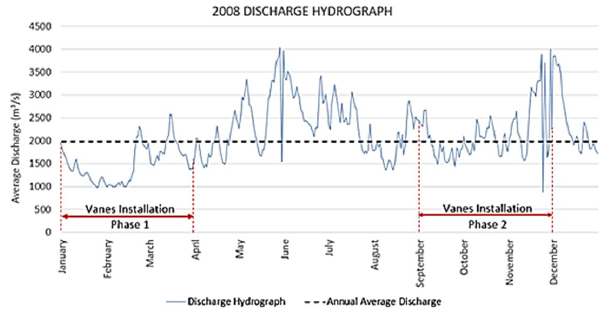
Figure 20. Cauca River, Guarumo: series of daily flows in 2008 (Source: La Coquera Station, IDEAM).